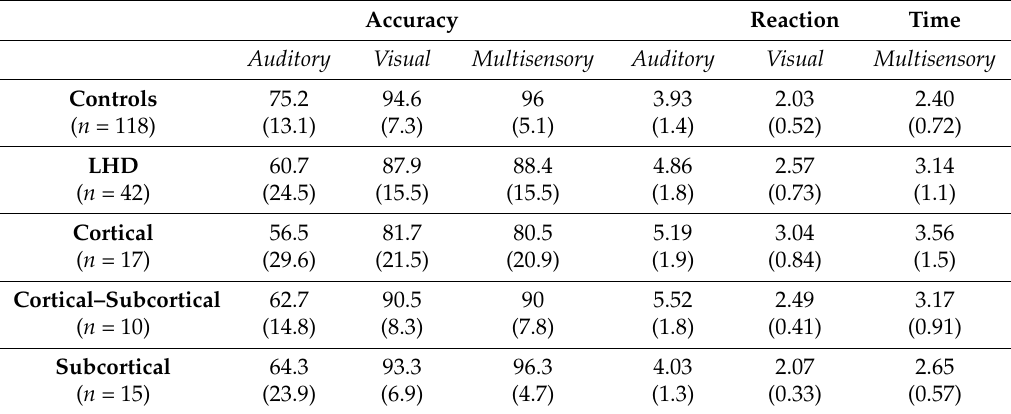
Table 3. Mean (SDs) of naming accuracy (%) and reaction time (seconds) by condition. Accuracy Reaction Time Auditory Visual